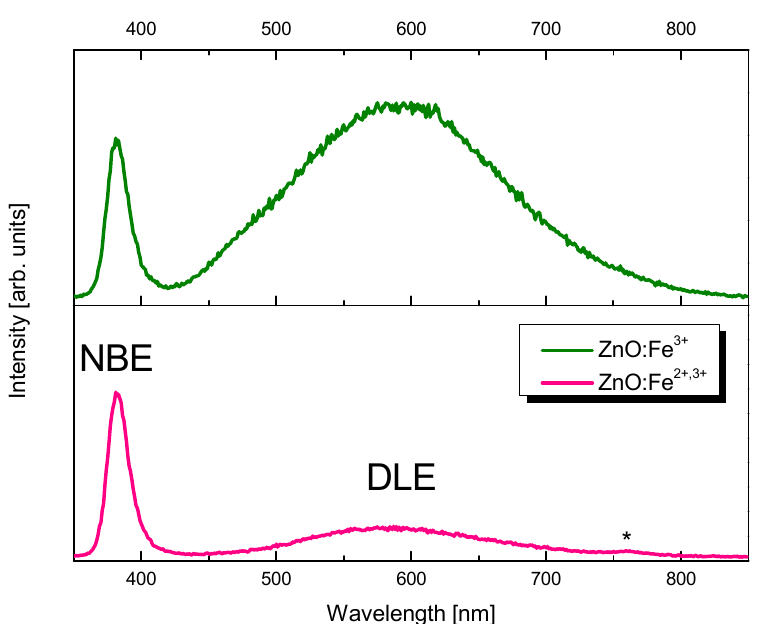
Figure 5. Cathodoluminescence of ZnO:Fe 3+ (upper) and ZnO:Fe 3+,2+ (lower) nanoparticles. Asterisk shows measurement artifact. NBE—near bandedge emission, DLE—deep level emission.